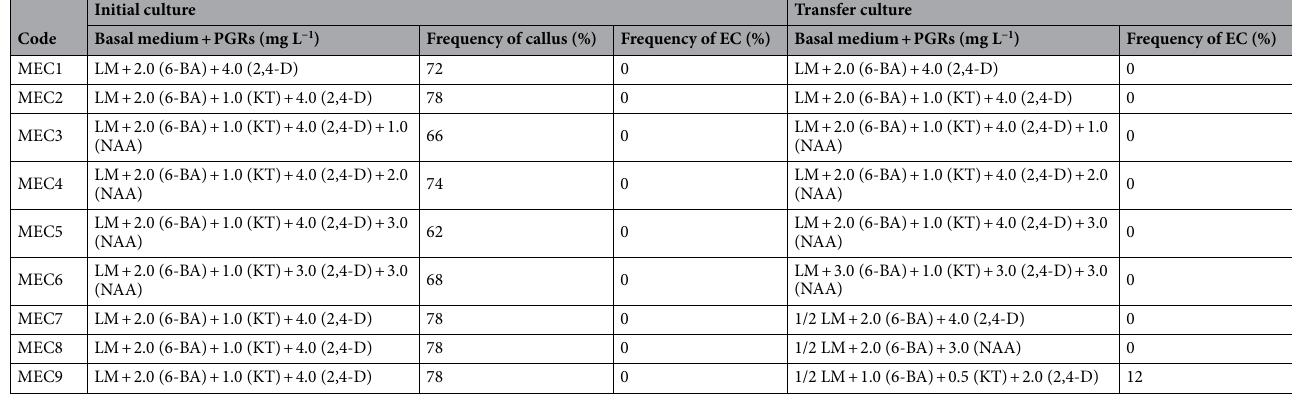
Table 1. The medium combinations for inducing EC from mature zygotic embryo.